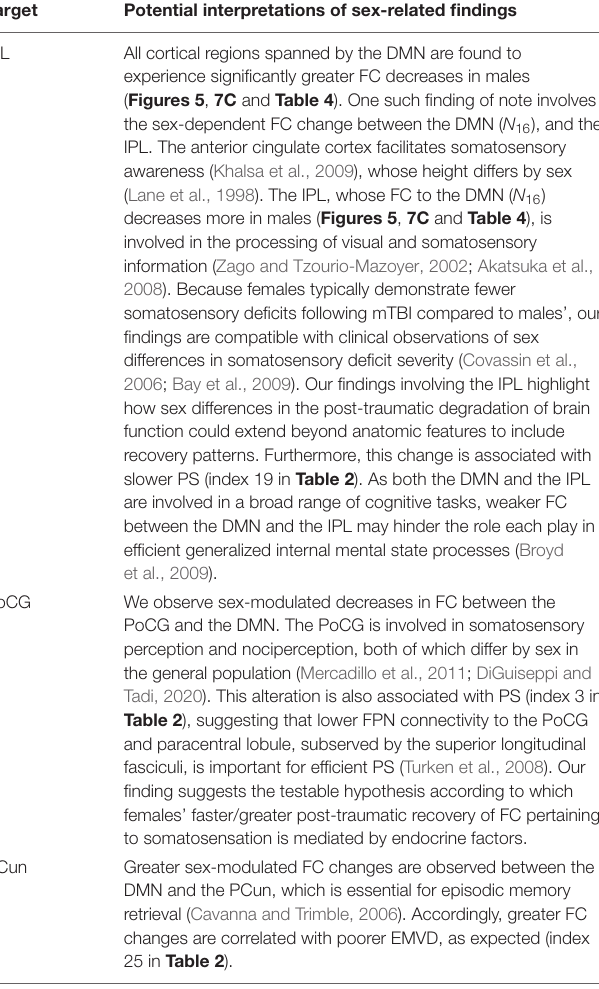
TABLE 10 | Like Table 5 , for the FPN. TABLE 11 | Like Table 5 , for the DMN.